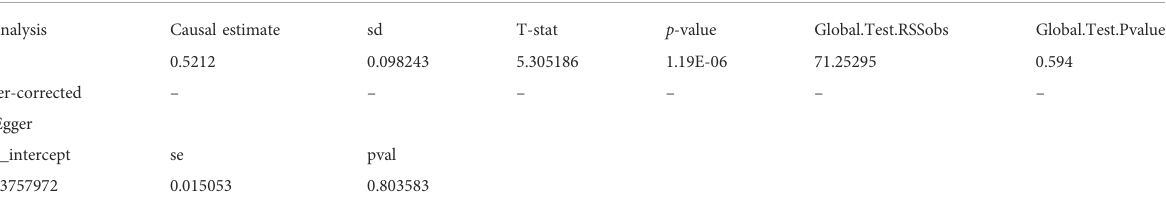
TABLE 3 Pleiotropy test.